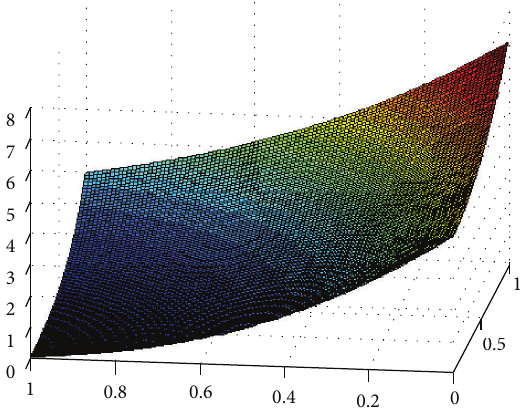
Figure 7: Graphical representation of the Snell